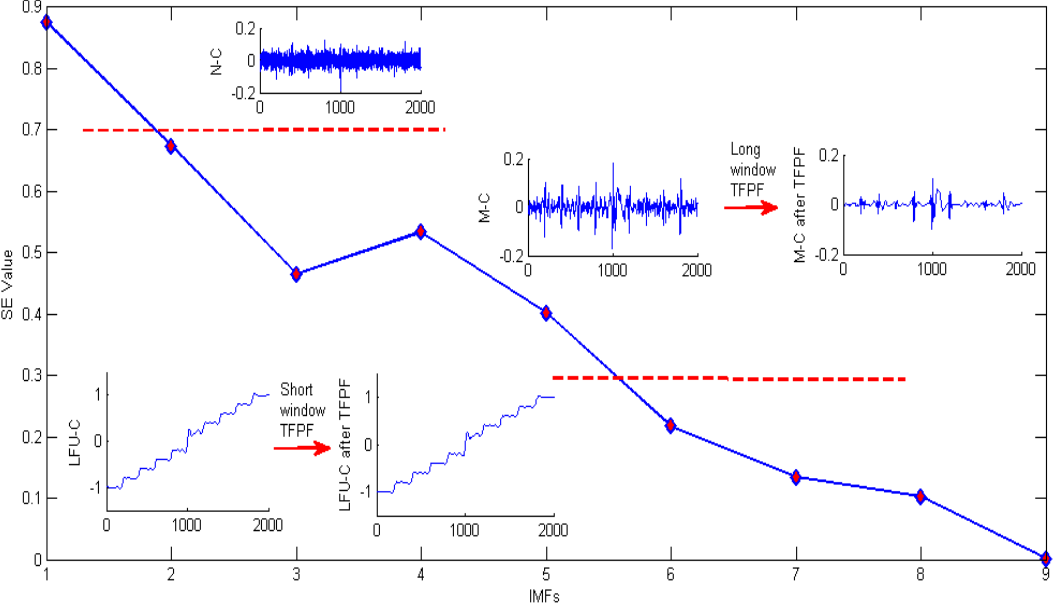
Figure 8. Detailed de-noising process of SEEMD-TFPF for rotation signal.